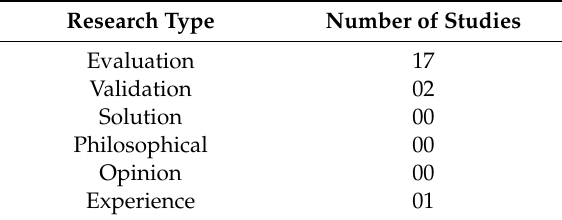
Table 6. Number of studies classified on basis of research